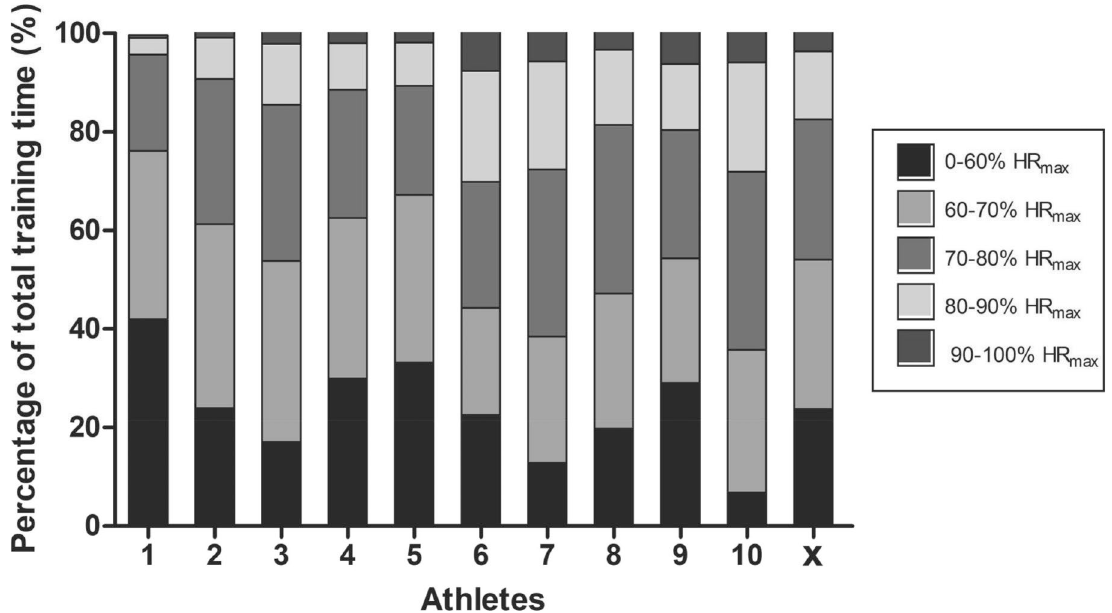
Figure 1 - Time spent at five different exercise intensities, determined by the maximum heart rate percentage, during gymnastic training sessions. Each bar represents one athlete, and the “X” bar represents the mean group response. HR max = maximum heart rate.